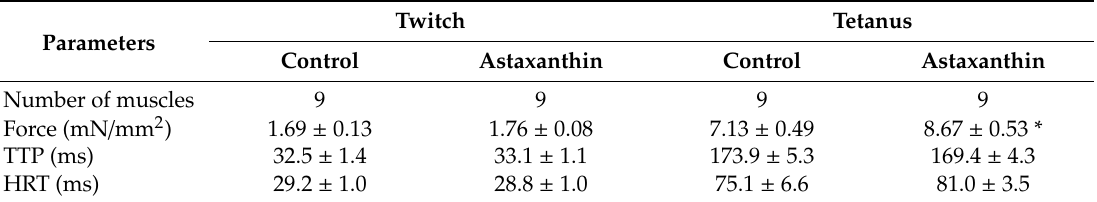
Table 1. Force parameters from 9 control and 9 AX treated